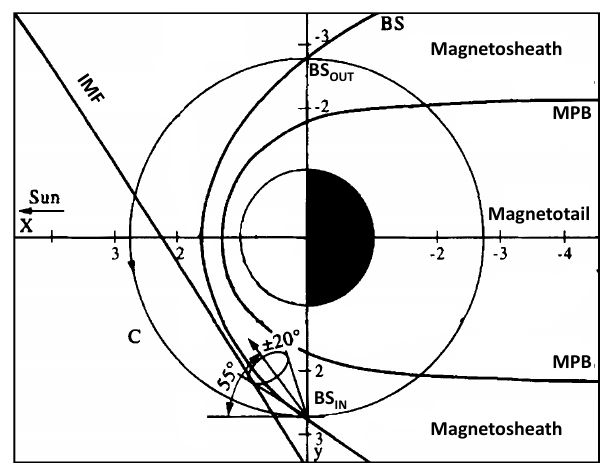
Fig. 1. A schematic illustration of the attitude of the SLED tele- scopes, the orbits of Phobos-2 and the main plasma regions. The figure shows representative encounters of Phobos-2 with Mars as in- dicated by plotting a circular orbit (C). Also represented are the bow shock (BS), the magnetosheath, magnetic pileup boundary (MPB), the magnetotail and the direction of the interplanetary magnetic field (IMF). The data analysed in this paper come from one of the circular orbits traversed. The conical shape illustrates the field of view of the SLED instrument while traversing a circular orbit near the terminator